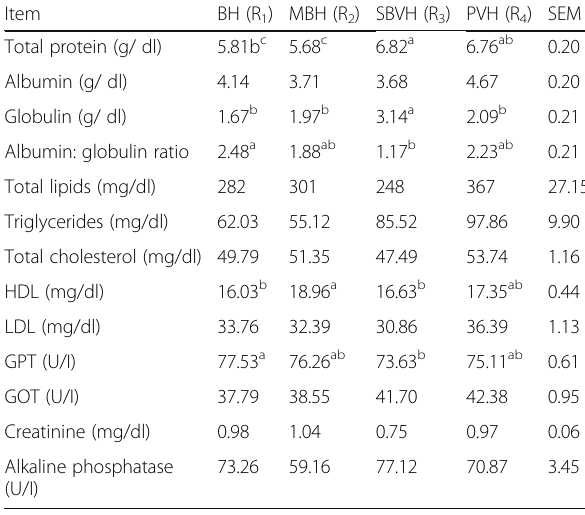
Table 8 Blood parameters of the experimental groups